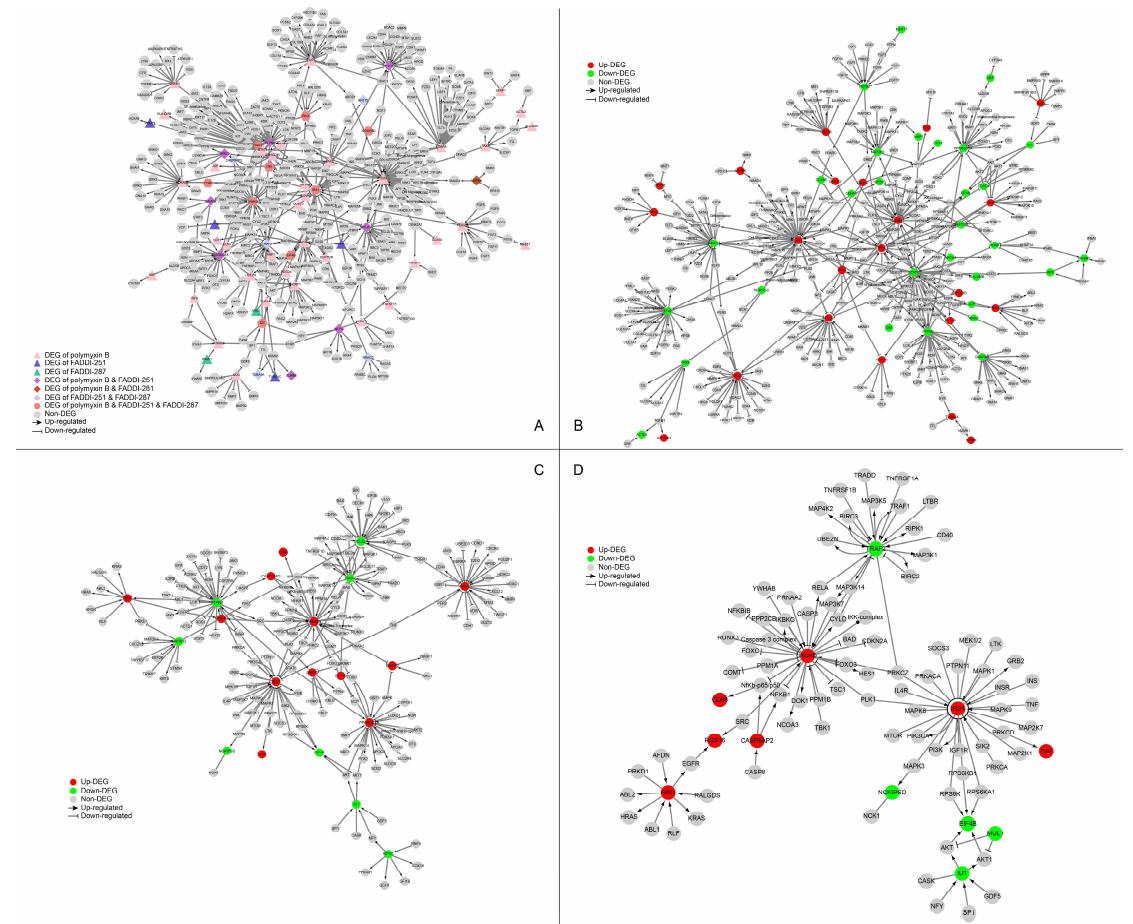
Figure 5. Perturbation of the signaling network of HK-2 cells by polymyxin B, FADDI-251 and FADDI-287. ( A ) Perturbation of the signaling network by any polymyxin. Triangle nodes rep- resent the DEGs induced by only one polymyxin, diamond nodes represent the DEGs induced by two polymyxins and hexagon nodes represent the DEGs induced by all the three polymyxins. ( B – D ) Perturbation of the signaling network by polymyxin B, FADDI-251 and FADDI-287, respec- tively. Red nodes represent the upregulated DEGs induced by polymyxin, and green nodes represent the downregulated DEGs induced by polymyxin. Enlarged for